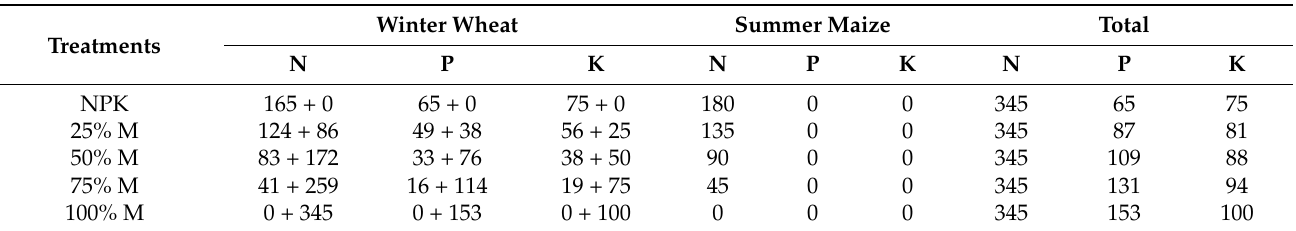
Table 1. Details of fertilizer treatments and fertilizer rates for winter wheat–summer maize cropping system (kg ha − 1